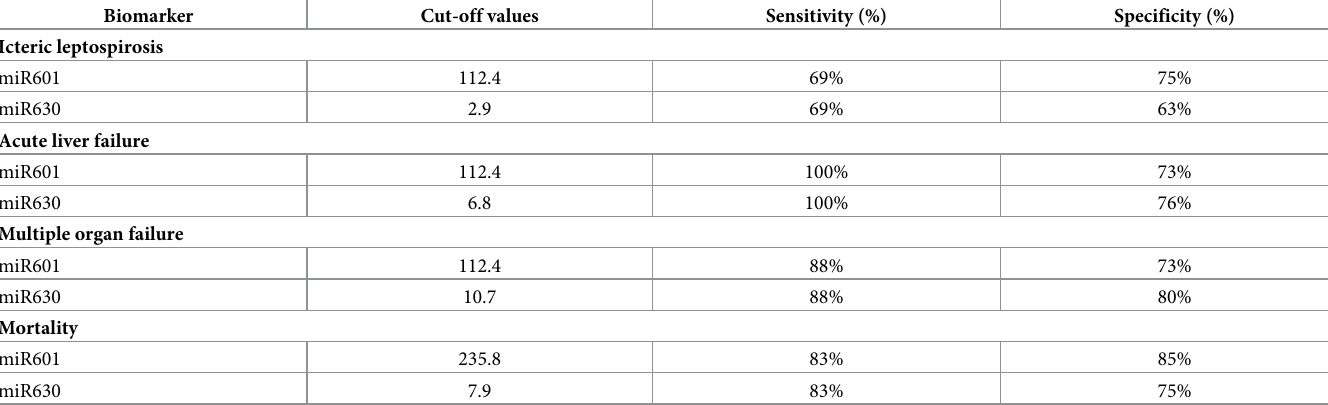
Table 2. The sensitivity and specificity of serum miR-601 and miR-630 in the diagnosis of icteric leptospirosis, acute liver failure, multiple organ failure and mortality. Biomarker